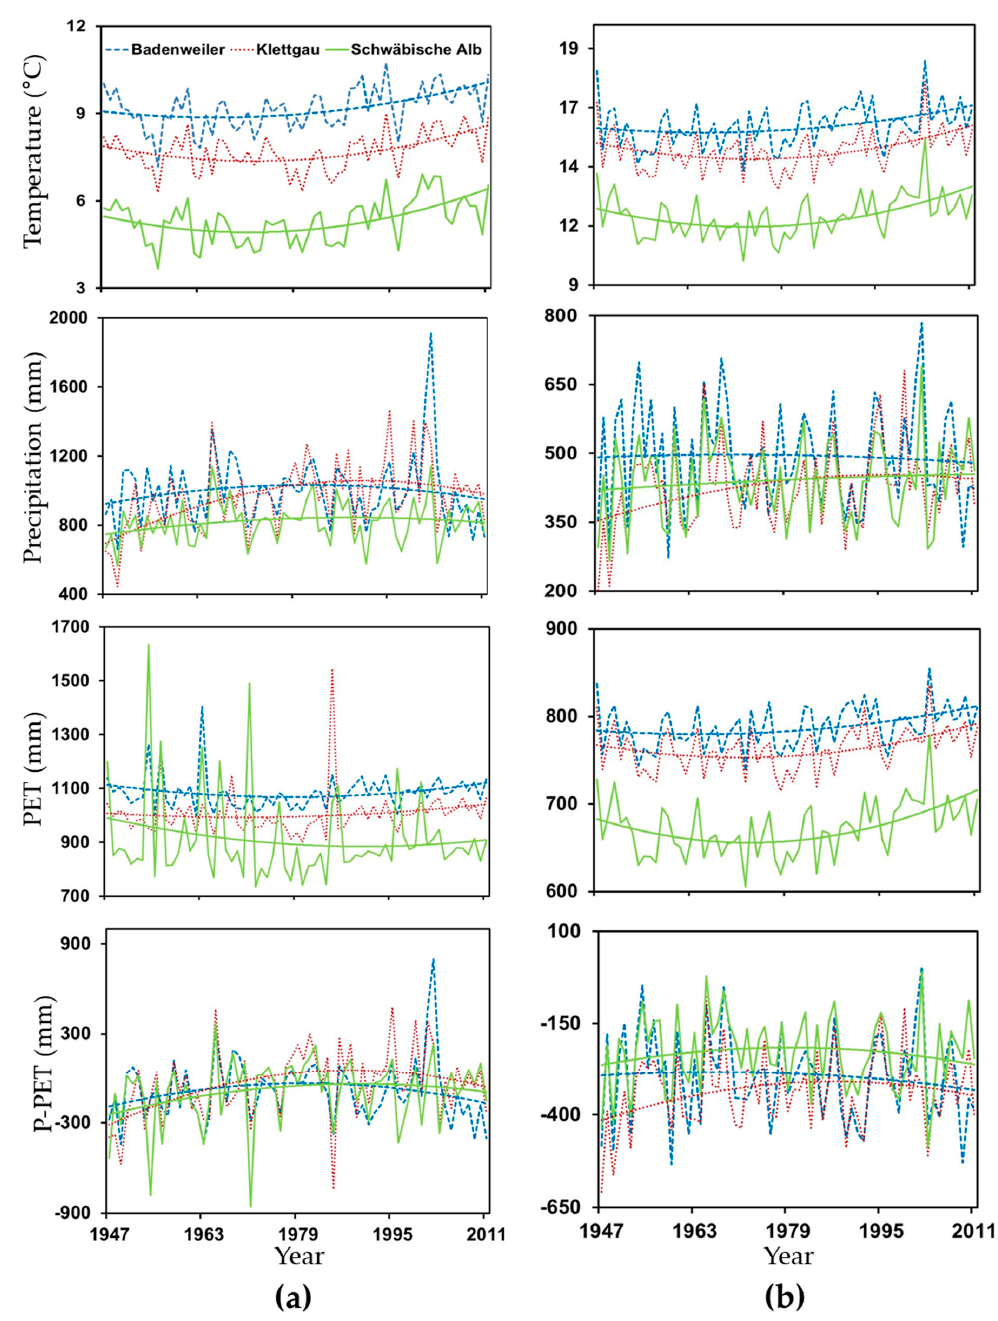
Figure 5. Mean temperature, measured in degree centigrade (°C), total precipitation, total potential evapotranspiration (PET), and precipitation–potential evapotranspiration (P-PET), all measured in millimeter (mm) for the three study locations from 1947 to 2011 with the separate trend line. All graphs on left-hand side, denoted by ( a ), are for the entire year, whereas all graphs on right hand side, denoted by ( b ), are for the growing season (May–September). Graphs in rows are for temperature, precipitation, potential evapotranspiration (PET), and drought index (P-PET) from top to bottom, respectively.